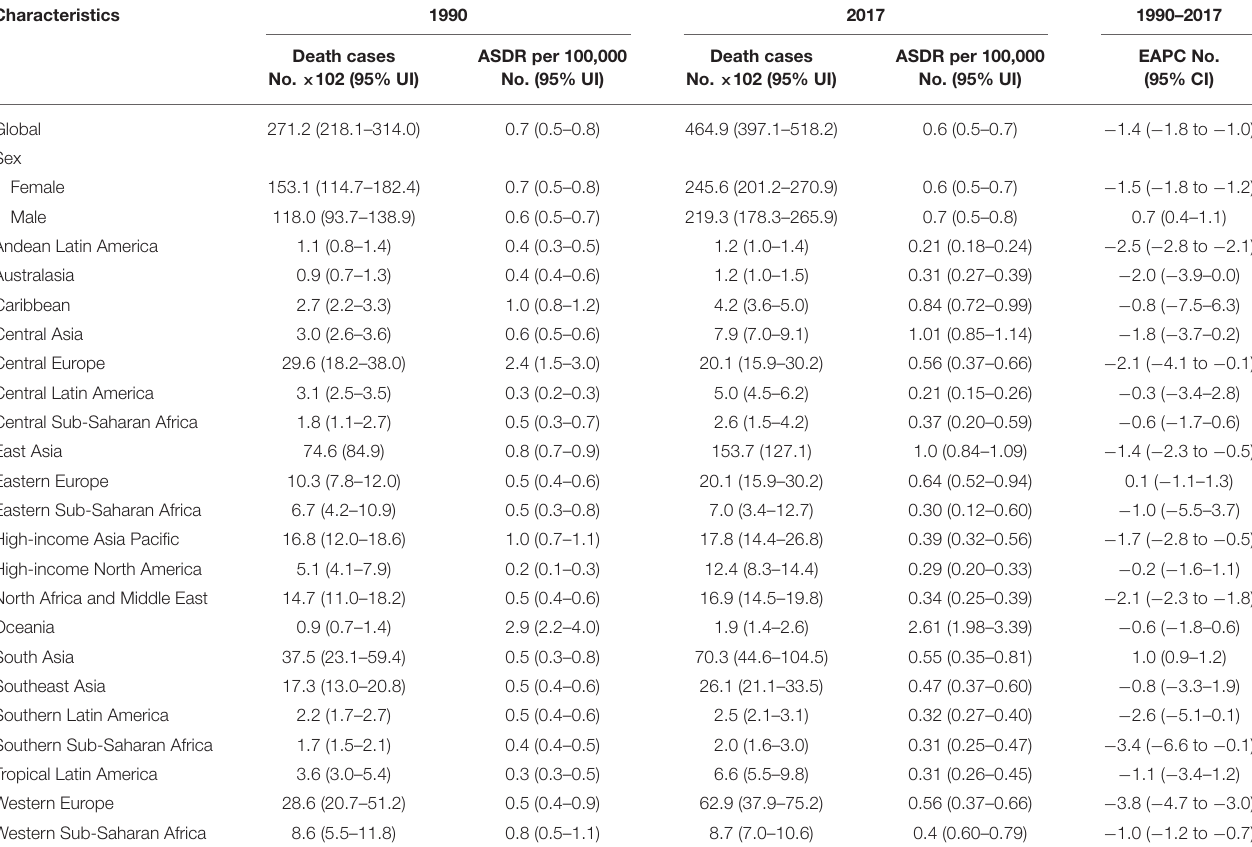
TABLE 2 | The death cases and age-standardized death rate of myocarditis between 1990 and 2017 and its temporal trends from 1990 to 2017.